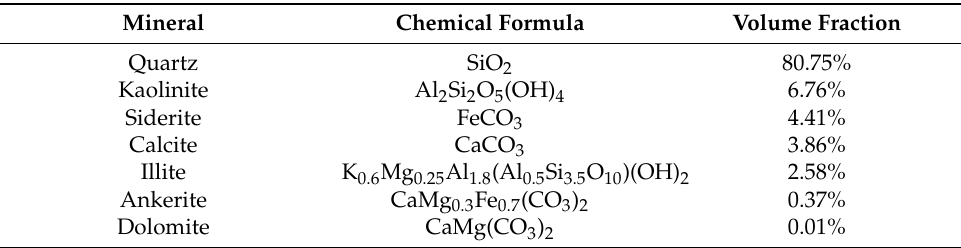
Table 2. Major minerals at the FWU and volume fractions